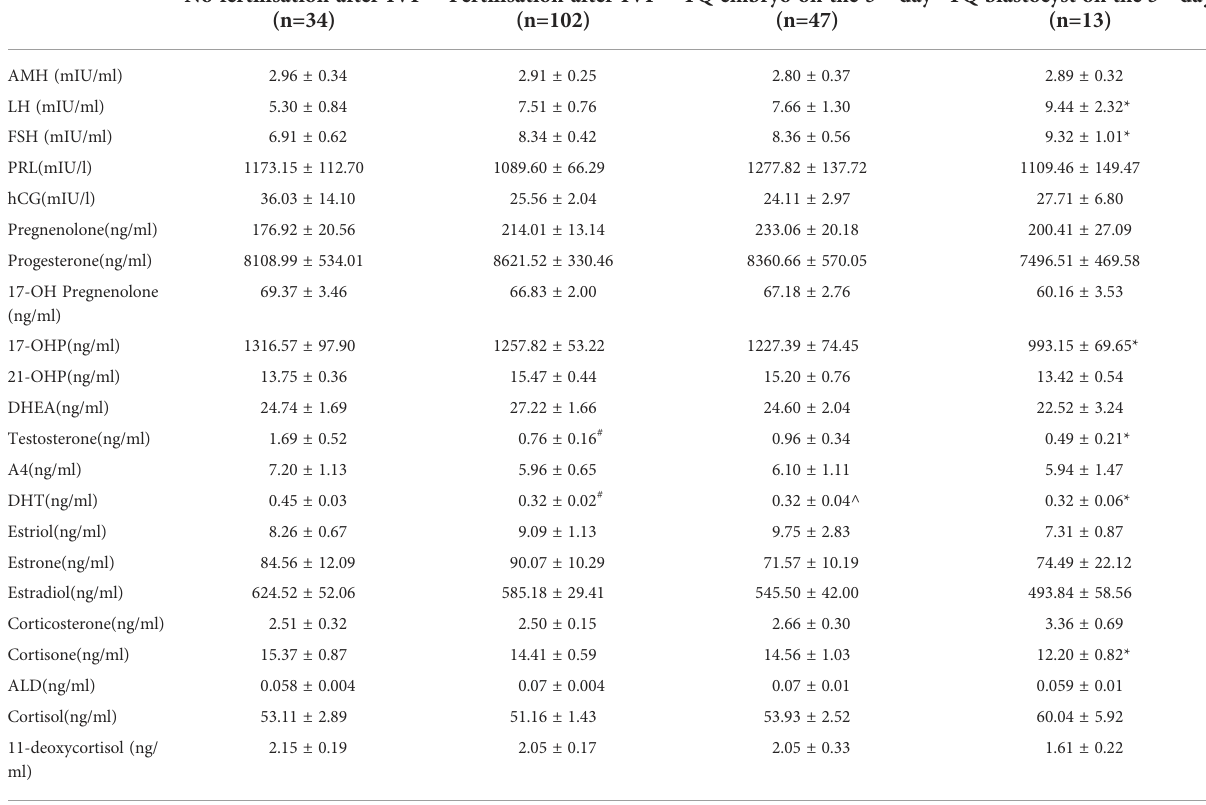
TABLE 2 Distribution of steroid and gonadotropic hormone concentrations in FF in relation to the corresponding oocytes: fertilisation and subsequent embryo